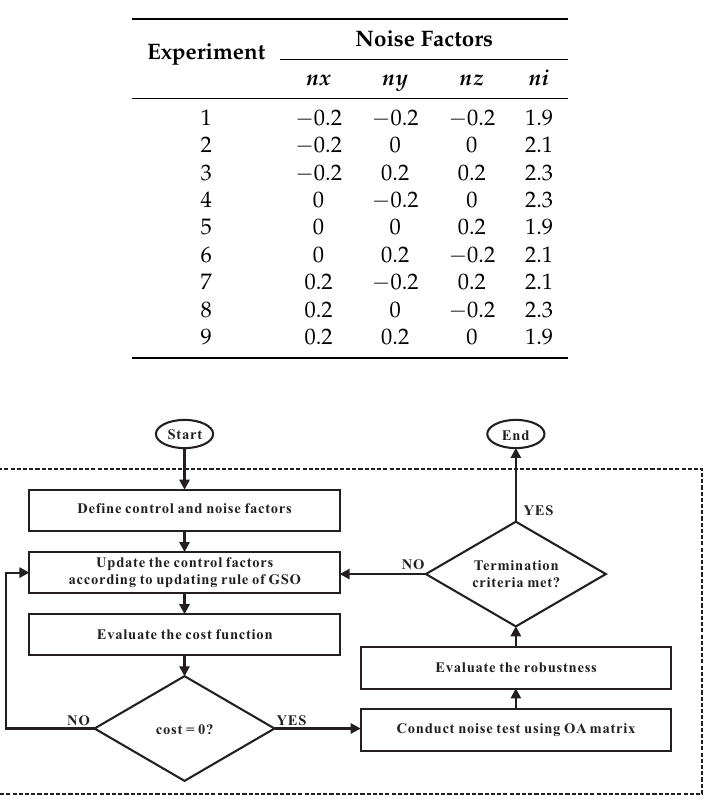
Table 1. OA Matrix for noise factors.